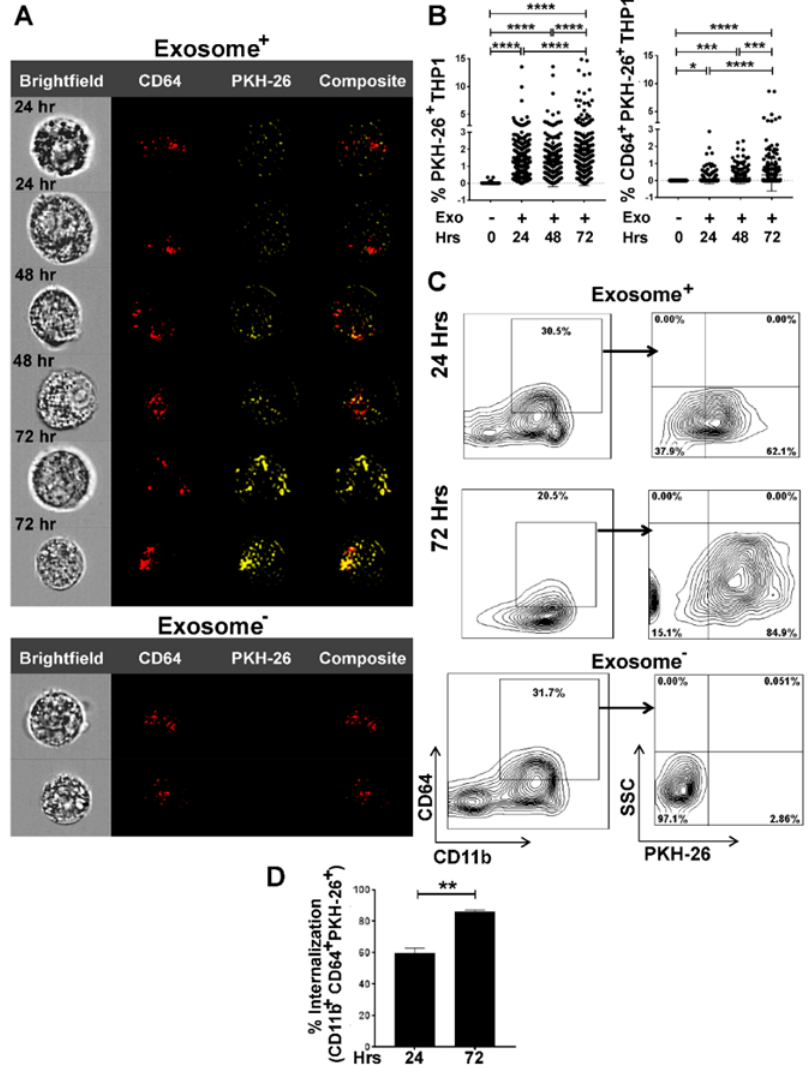
Figure 2. ImageStream and flow cytometry analyses quantify time-dependent internalization of tumor cell-derived exosomes by THP-1 cells. THP-1 cells were seeded and differentiated into M0 macrophages upon overnight stimulation with PMA (20–100 ng / mL). M0 macrophages were then co-cultured with PKH-26 stained A549-derived exosomes in 10:1 ratio (10 exosomes / cell) for 24 to 72 h. Image Stream analysis showing Bright field, CD64 + , PKH-26 + , and composite images. ( A ) Time-dependent internalization of exosomes by CD64 + populations assessed by internalization of PKH-26 stained A549-derived exosomes. CD64 + population, without internalization indicates M0 phenotype. ( B ) MATLAB analysis of percentage of PKH-26 + and CD64 + PKH-26 + signals to show time-dependent internalization of exosomes. Fluorescent signals were collected from 300 cells for each time point. ( C ) Representative flow cytometry of exosome internalization analysis at 24 h and 72 h. Group comparisons of 24 h exosome-, 24 h exosome + , and 72h exosome + were made. After co-culture, cells were prepared for flow cytometry and stained with CD64, CD11b, and PKH-26. The experiment was repeated twice, with three replicates per sample in each experiment. Exosome- sample was used as control ( D ) Percentage of internalization by THP-1 macrophages as CD11b + CD64 + PKH-26 + showing a significant increase of uptake in 72 h compared to 24 h * p < 0.05, ** p < 0.01, *** p < 0.001, **** p < 0.0001. Dot plots from ImageStream flow cytometry analyses were consistent with the MATLAB data also supporting a time-dependent exosome internalization (Supplementary Figures 1A,1B). Flow